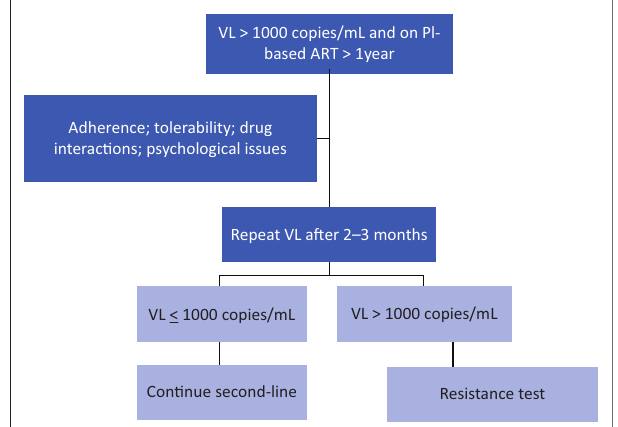
TABLE 7: Choice of second-line nucleoside reverse transcriptase inhibitors in relation to first-line nucleoside transcriptase inhibitors used. First-line NRTIs used